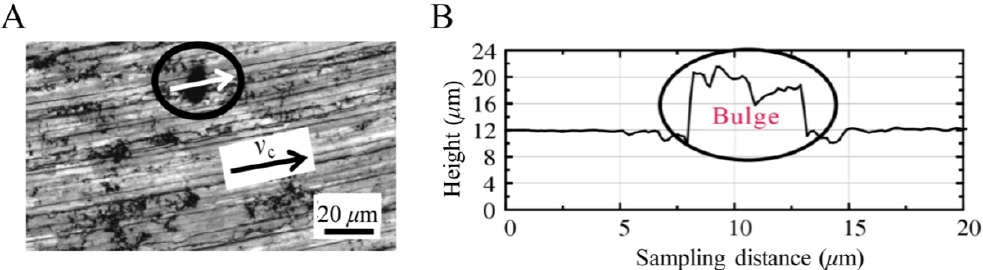
Figure 27. Typical surface bulge [25]. ( A ) Surface sampling location. ( B ) Two-dimensional mor- phology.